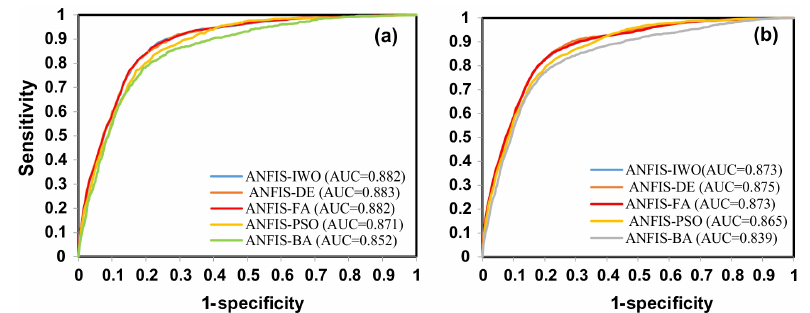
Figure 10. (a) Success rate and (b) prediction rate of the five models.